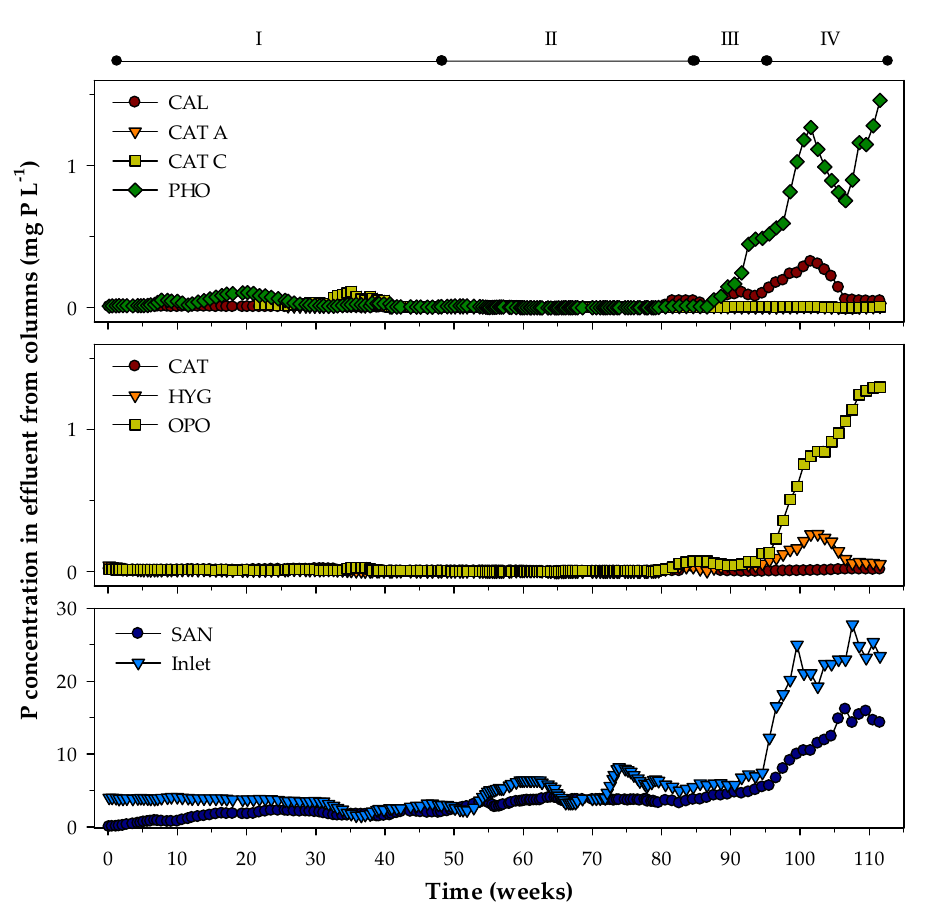
Figure 2. The P concentration in effluent from the 8 materials and in the inlet tank (running mean, n = 5). The operation period of I–IV is indicated at the top of the figure. Be aware of different y-axis scale for the SAN material and the inlet tank (lowest panel).